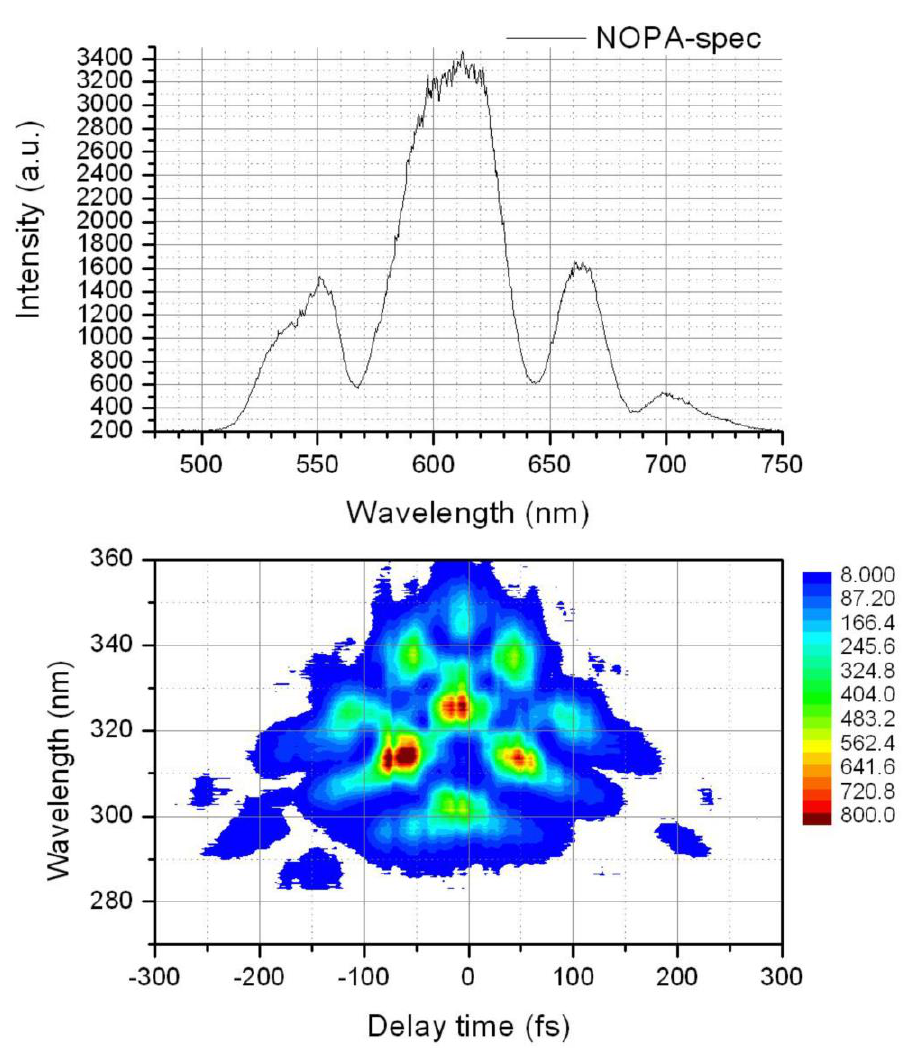
Figure 8. ( a ) Amplified signal spectrum. ( b ) Two-dimensional results of a FROG Figure 8. (Color online) ( a ) Amplified signal spectrum. ( b ) Two-dimensional results of a FROG measurement.